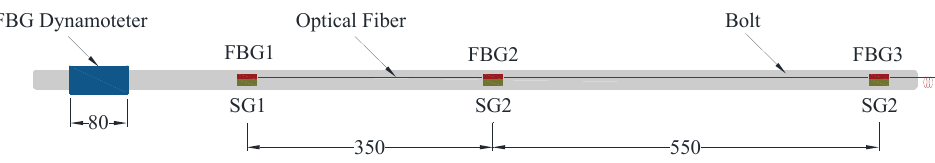
Figure 5. FBG force-measuring bolt.